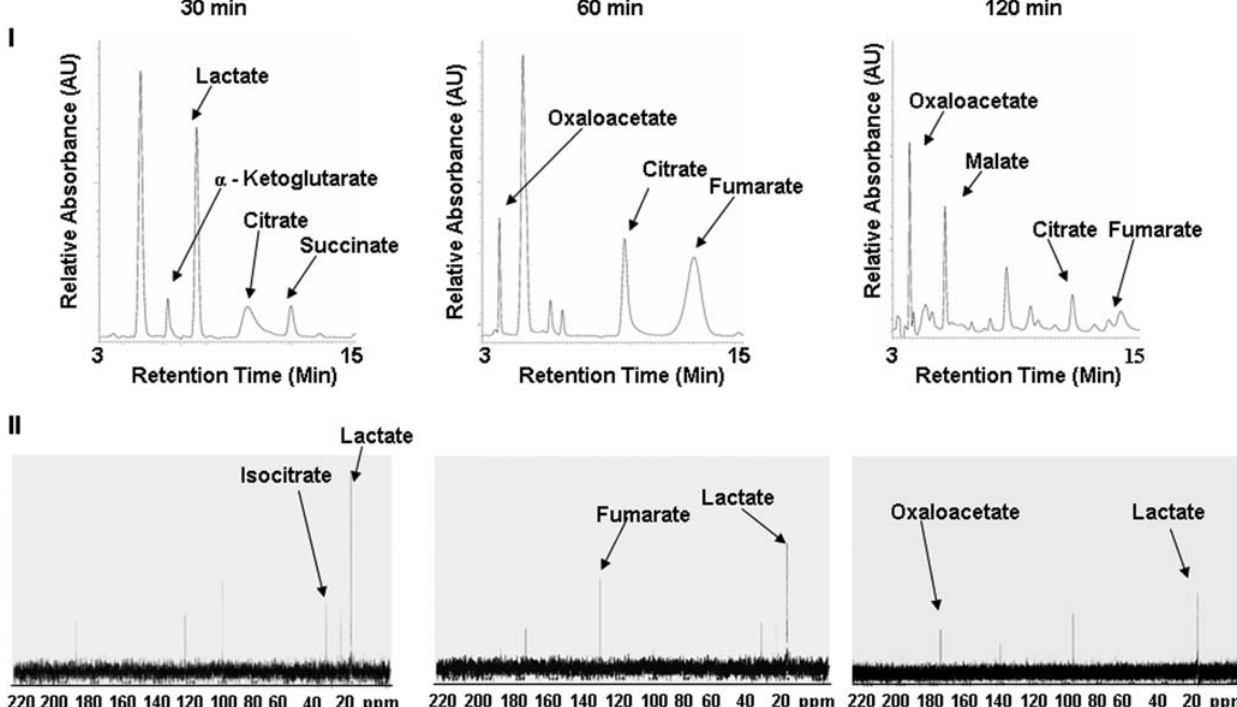
Figure 4. Oxidative metabolism of lactate in astrocytic mitochondria. Mitochondria isolated from CCF-STTG1 cells were incubated in 10 mM 13 C + and 1 m M NaN 3 –lactate, 0.1 mM NAD 3 for varying time intervals. Accumulation of TCA cycle intermediates were measured via I) HPLC and II) NMR spectroscopy. HPLC fractions were also confirmed by enzymatic assays (citrate, succinate, and fumarate).